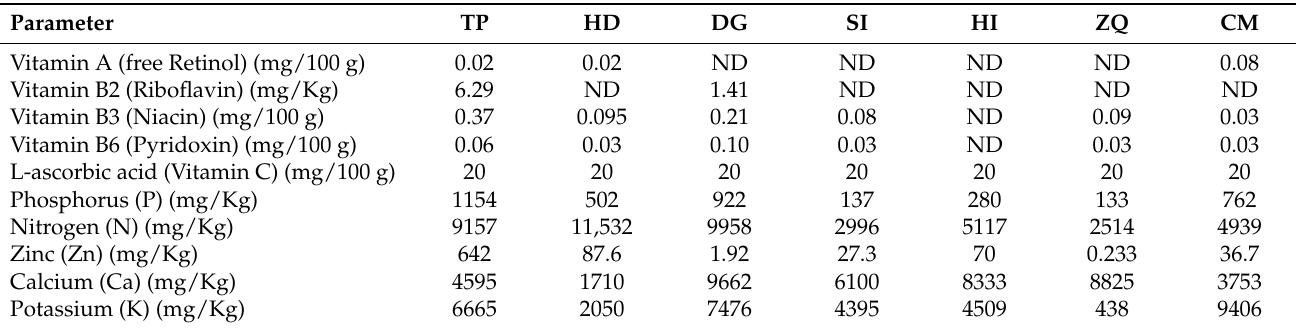
Table 4. Composition of vitamin and minerals in the